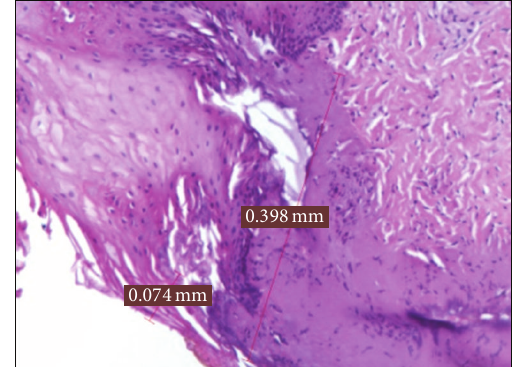
Figure 6: Histological specimen F 4 , using 4 watt in PW at 50 Hz, colour EE, magnification from original 40x.